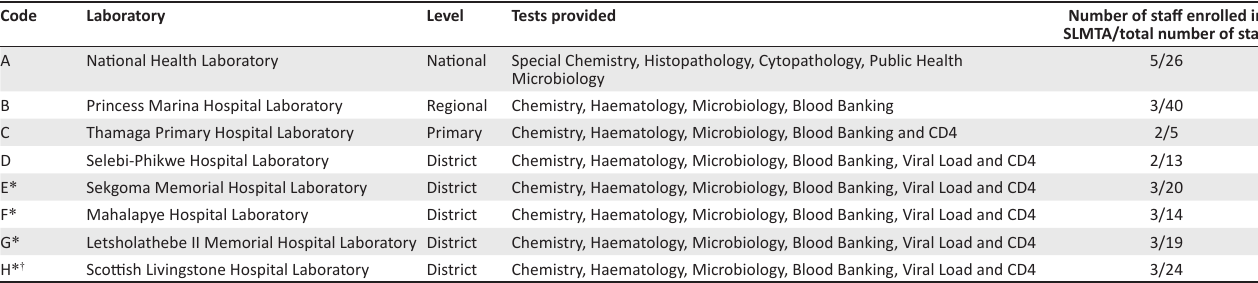
TABLE 1: Profiles of laboratories enrolled in the Botswana SLMTA programme, 2010.